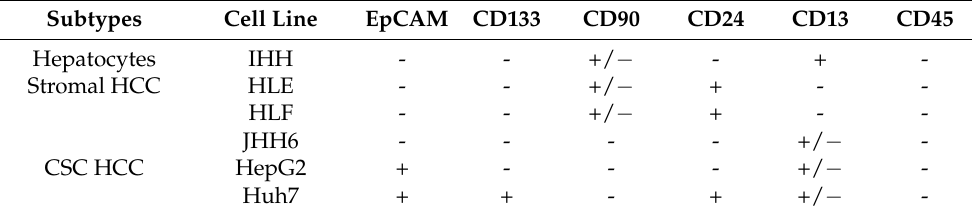
Table 3. The presence of CSC marker phenotypes in hepatic cell lines by flow cytometer. Subtypes